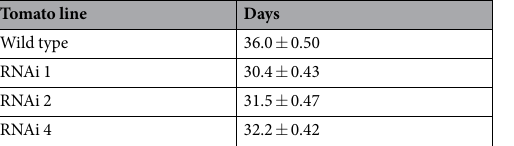
Silencing SlHDA1 accelerates fruit ripening and enhances carotenoid accumulation. The wild type and transgenic tomato plants were grown under normal conditions. Flowers were tagged at anthesis, and the time from the anthesis to ripening stage was measured for the wild type and transgenic lines. Color changes were observed earlier in SlHDA1 RNAi fruits compared with wild type (Fig. 1E). The ripening time was reported to be 3–6 days earlier in RNAi lines as compared to WT plants(Table 1). It was reported that the dramatic color change from green to red in tomato fruits is caused by chlorophyll degradation and accumulation of carote- noids 25 , including lycopene (red) and β -carotene (orange) 10, 25 . In this study, total Chl and carotenoids in the RNAi lines and wild type fruits at B, B + 4 and B + 7 stages were extracted and determined. As shown in Fig. 2A, total Chl decreased by approximately 50–60% in transgenic lines compared with wild type fruits at the B + 4 and B + 7 stage, and a 15–20% decrease was observed in RNAi lines of fruits at the B stage. In contrast, the total carotenoids increased by 30% in RNAi fruits compared with wild type fruits (Fig. 2B). To confirm the underlying causes of the differences in color and carotenoid accumulation between the SlHDA1 RNAi lines and wild type, the expression levels of carotenoid biosynthesis-related genes were meas- ured in the fruit pericarp of SlHDA1 RNAi lines and wild type from MG to B + 7 stages by quantitative RT-PCR (Fig. 3). The results displayed that PSY1 (Phytone synthease1) was up-regulated in RNAi fruits, while the expres- sion of CYC-B , LCY-B and LCY-E was remarkably down-regulated in RNAi fruits compared with wild type. These results indicate that silencing SlHDA1 affects fruit ripening in tomato.